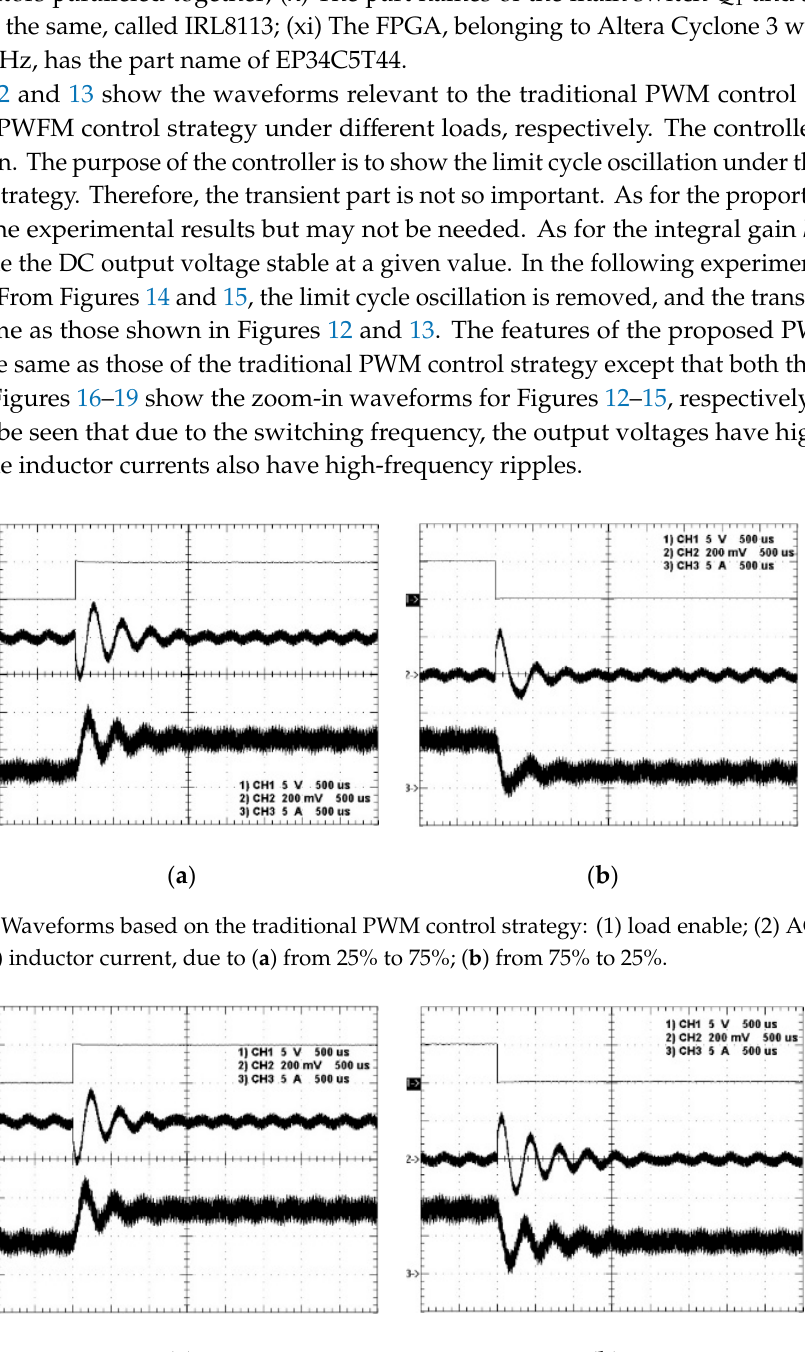
( b ) Figure 14. Waveforms based on the proposed PWFM control strategy: (1) load enable; (2) AC output voltage; (3) inductor current, due to ( a ) from 25% to 75%; ( b ) from 75% to 25%.